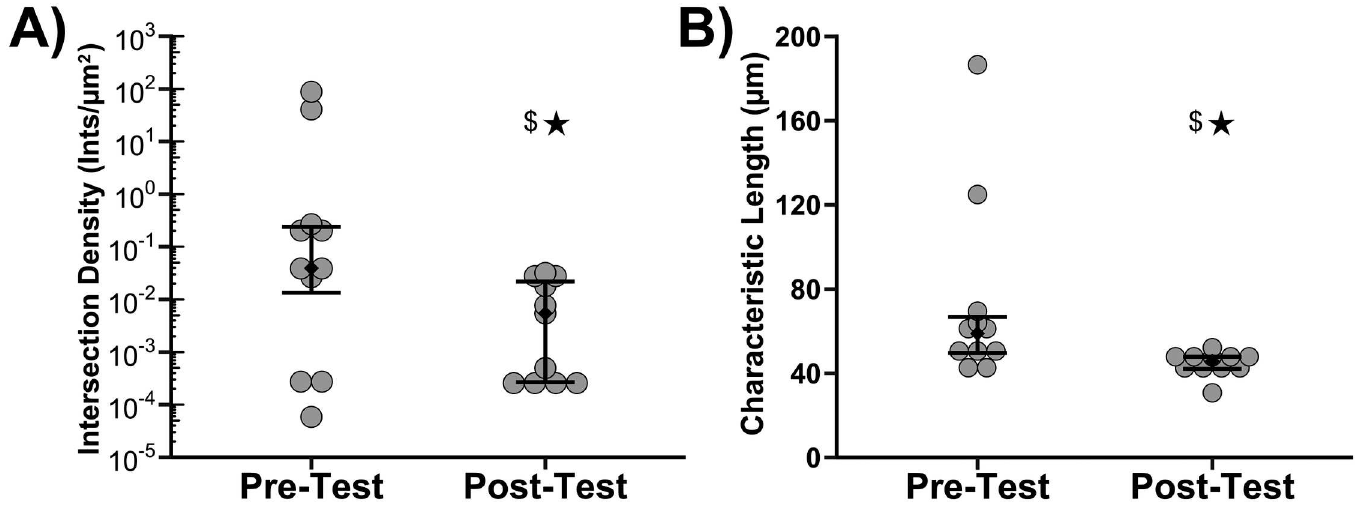
Fig 5. Plot of participant reported intersection density (A) and reported characteristic length between intersections (B) before and after training. Gray symbols are individual responses and diamonds are median with first and third quartiles(n = 11). Stars indicatethat varianceswere statisticallydifferent betweenthe Pre-Test and Post-Test (Flinger-Killeen’s Test, P < 0.05). Dollar sign indicatesmeans were statistically different betweenthe Pre-Test and Post- Test (WilcoxonSignedRank Test, P <